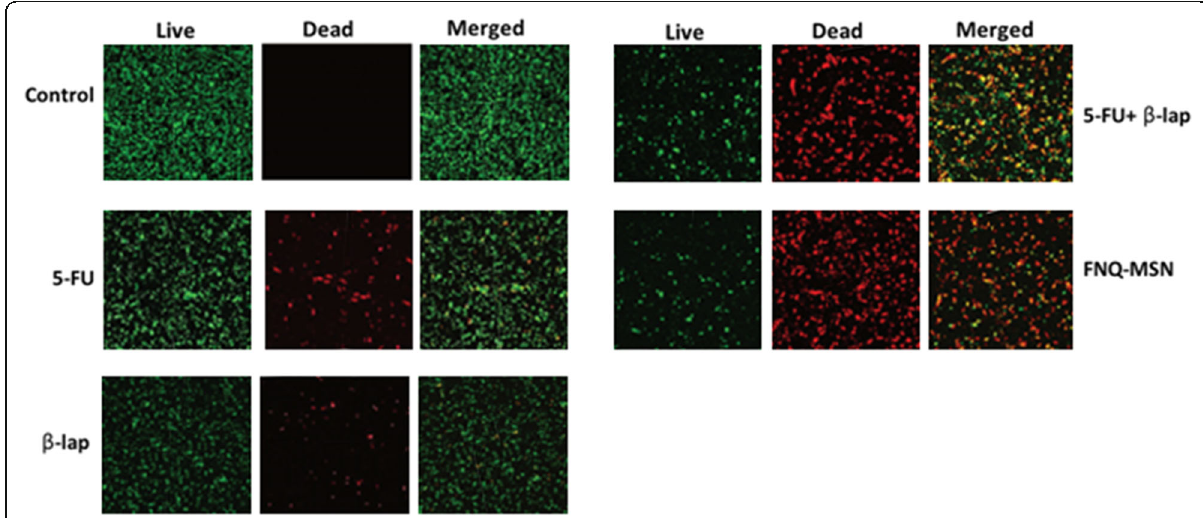
Fig. 7 Live/dead analysis of Cal33 cells using double staining of Calcein AM and ethidium bromide after treatment with individual and combination of 5-FU and